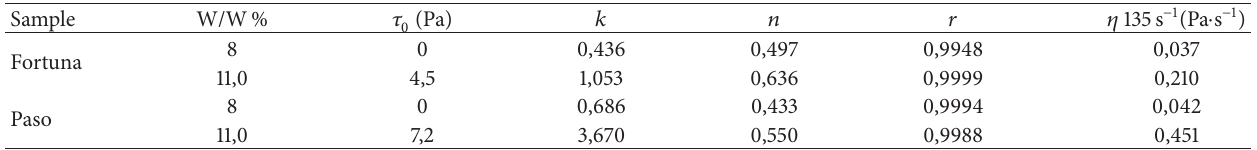
Table 4: Power law parameters ( 𝑘 and 𝑛 ), regression coefficient ( 𝑟 ), and viscosity at 135 s − 1 (Pa ⋅ s − 1 ), corresponding to flour dispersion at 8% and 11% solid concentration and for each rice